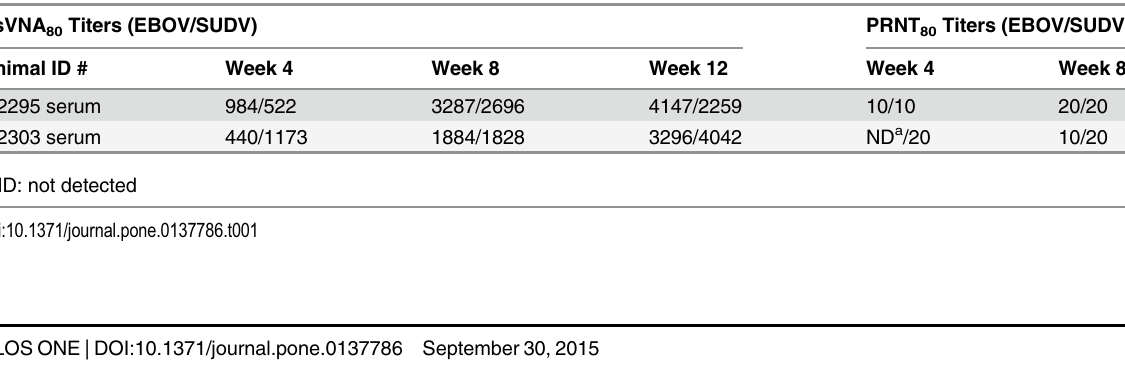
Fig 1. Production of human antibodies in TcBs. (A) Timeline of the vaccinations (black arrows), blood collections (red arrows) and plasma collections (blue arrows) for the TcBs. Serum samples obtained from two TcBs (#2295 and #2303) before vaccination (week 0) or 8 – 10 days after vaccinations 2 – 4 with EBOV-GP co and SUDV-GP co DNA vaccines were analyzed for total IgG antibodies by ELISA using (B) whole irradiated EBOV or SUDV antigens, and (C) EBOV rGP or SUDV rGP. Symbols represent the titers at each time point for each TcB. doi:10.1371/journal.pone.0137786.g001 Table 1. Serum neutralizing antibody responses of TcBs after vaccinations 2 –